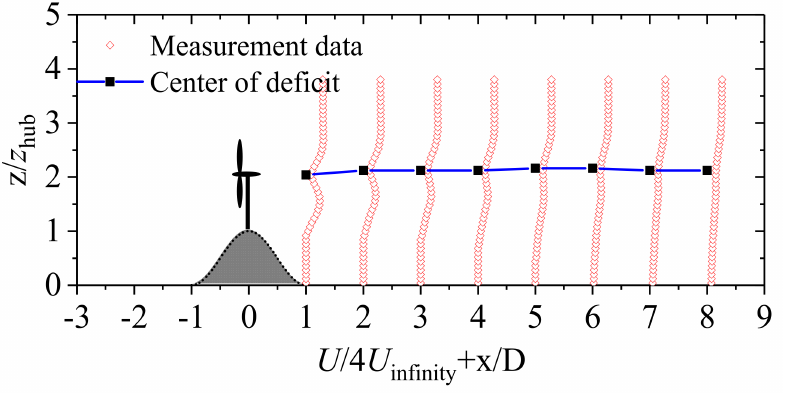
Figure 12. Wind turbine wake velocity distributions when sited on a hilltop (case